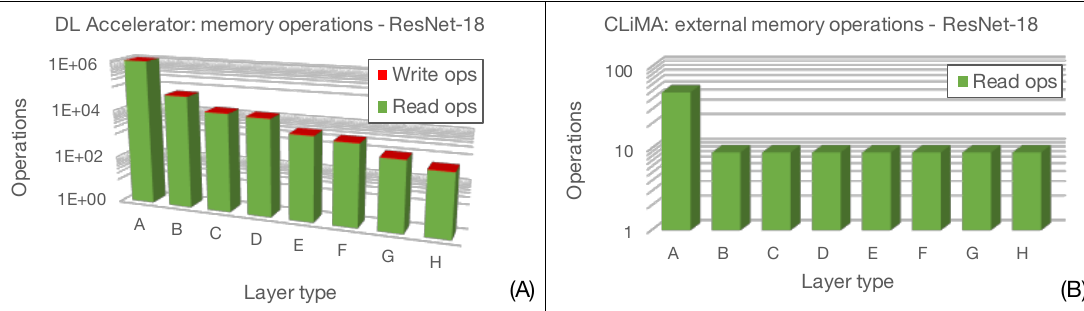
Figure 19. Memory access evaluation for ResNet-18 in ( A ) Deep Learning Accelerator and ( B )